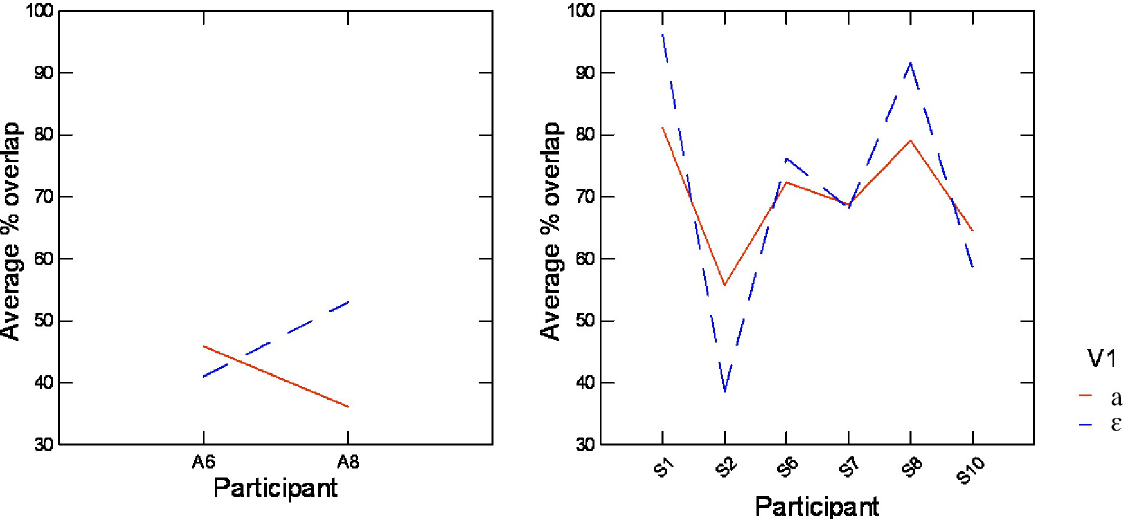
Fig 11. Average percent overlap in V 1 between V 1 C/i/ and V 1 C/a,/ per participant. The solid line corresponds to /a/CV 2 sequences and the dashed line corresponds to / ε /CV 2 sequences.